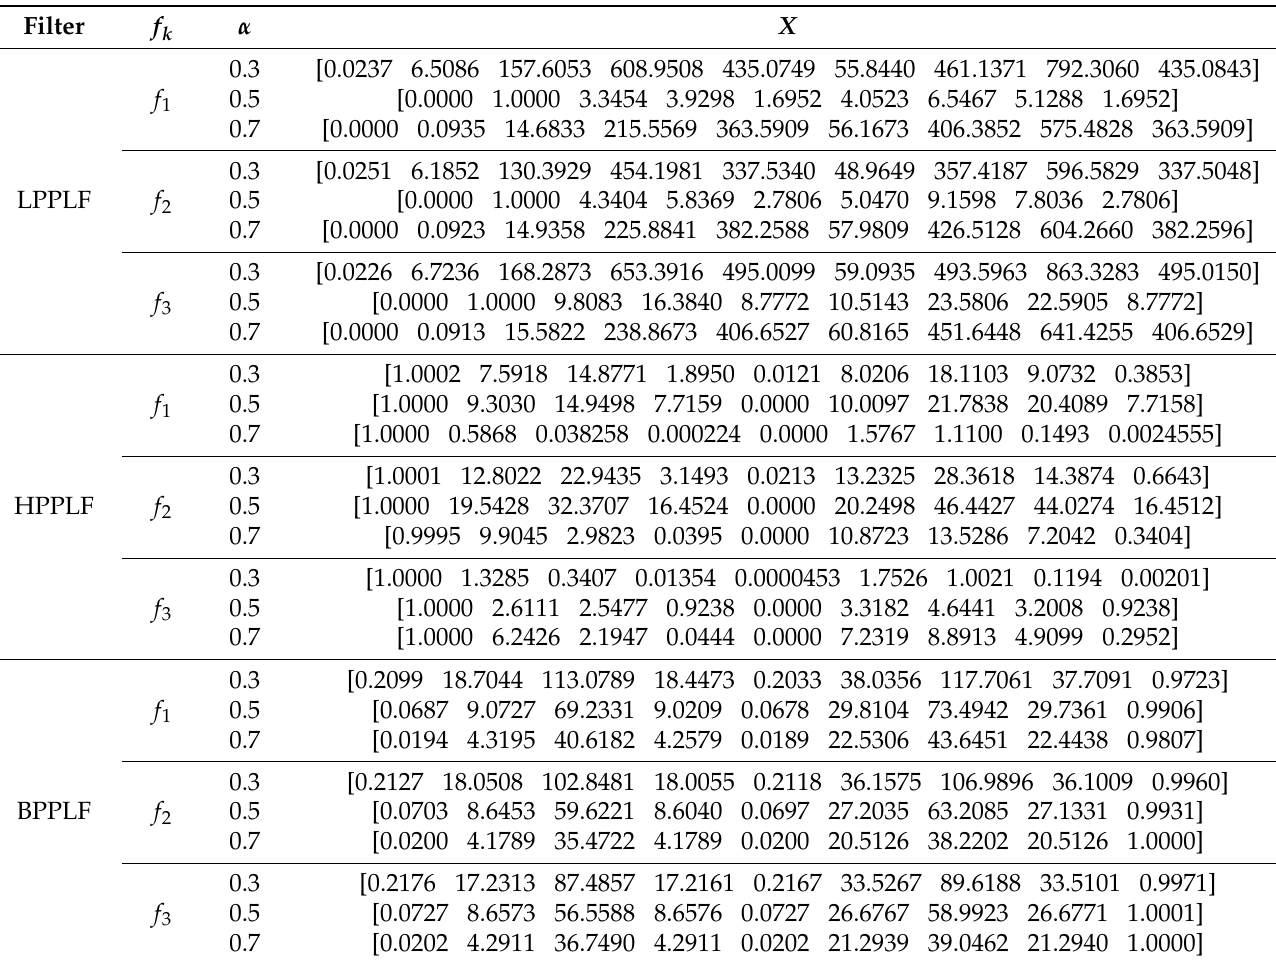
Table A1. Optimal coefficients of the designed PLFs based on different objective functions ( f k